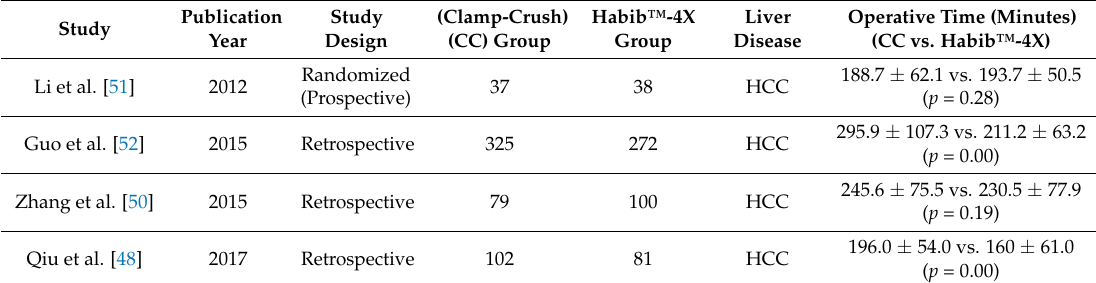
Table 2. Characteristics of studies included in the